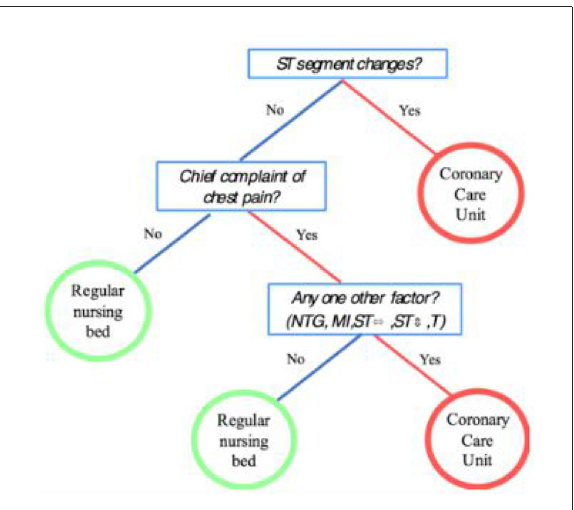
FIGURE8 A fast-and-frugal tree for patients with symptoms that may indicate the risk of heart